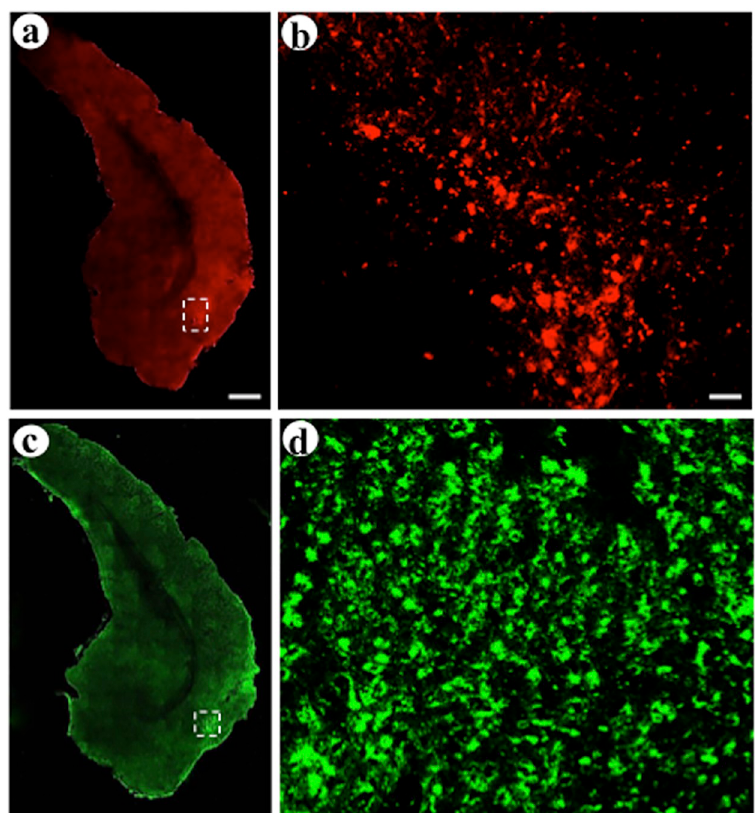
Fig 3. The locations of the pre- and postsynaptic injection sites in the middle or upper layers of POR cortex, and transduced neurons proximal to each injection site. (A and B) The presynaptic vector pGADdcv-secretogranin/ anti-GABA A ß2or3-HtoL/his-tag, His tag-IR (Texas red-conjugated secondary antibody); (A) low power view, and (B) high power view of the box in panel A showing transduced neurons. (C and D) The postsynaptic vector pINS-TH-NFHdendrite-gfp/gC–ZZ+anti-His tag, GFP-IR (FITC-conjugated secondary antibody); (C) low power view, and (D) high power view of the box in panel C showing transduced neurons. Scale bars: (A and C) 1,200 μ m; (B and D) 50 μ